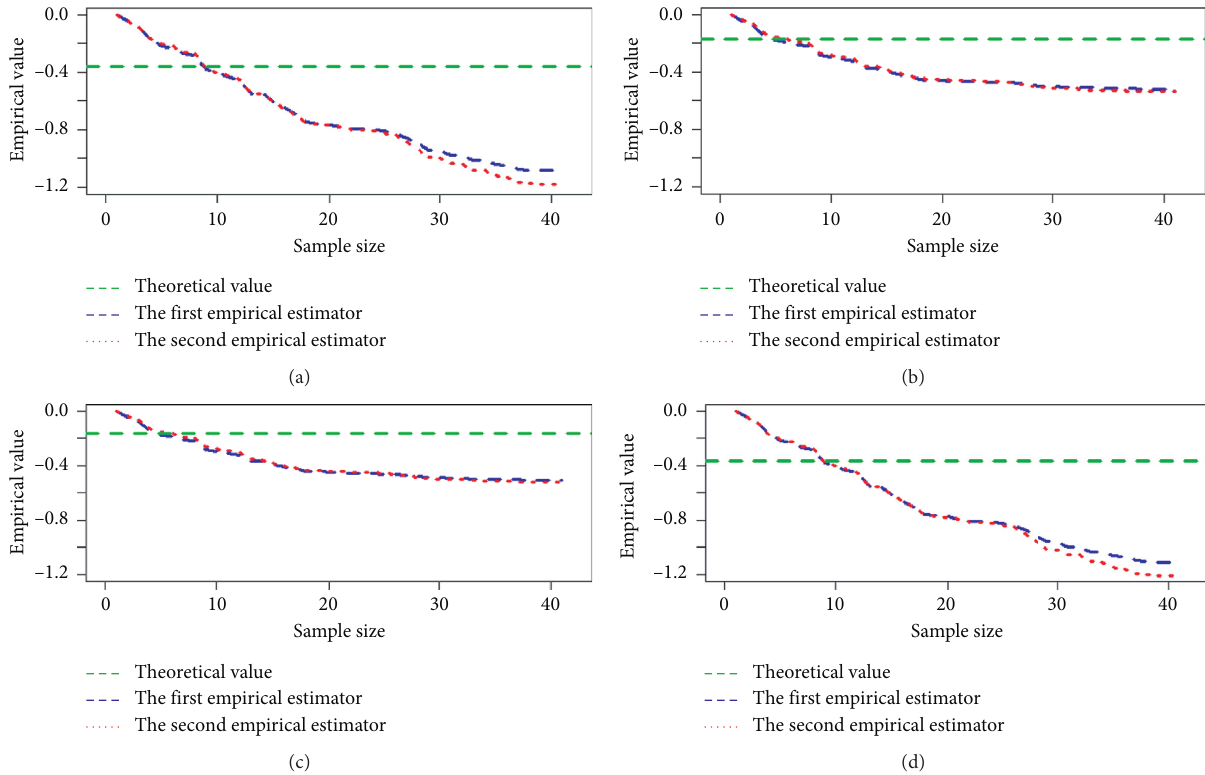
Figure 2: Empirical estimators of serious cases of infected COVID-19 virus data. (a) α � 0 . 8 ,n � 40 , r � 35. (b) α � − 0 . 8 ,n � 40 , r � 35. (c) α � 0 . 8 ,n � 40 , r � 10. (d) α � − 0 . 8 , n � 40 ,r � 10.